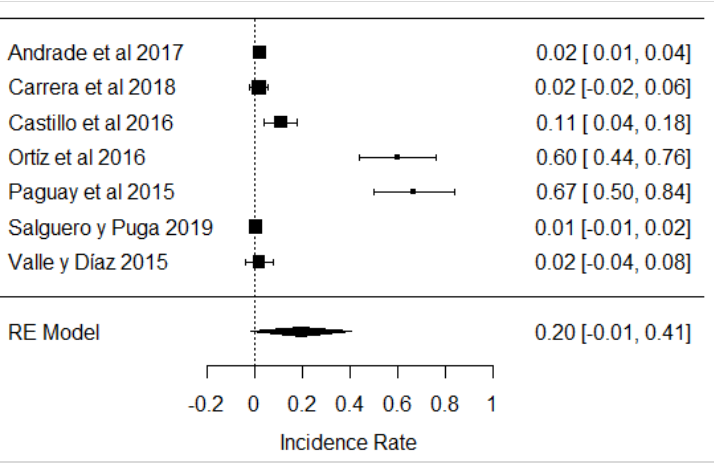
Figure 17. Forest plot of antibiotic [21,23,26,27,31,32,36,38,39,43,44,46,48–50,62,66,79,82].